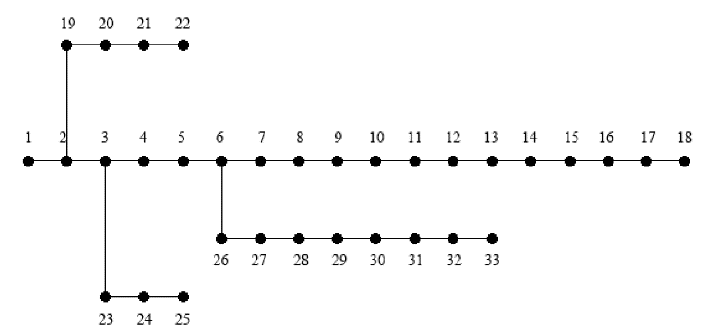
Figure 8. The 25-node traffic network.